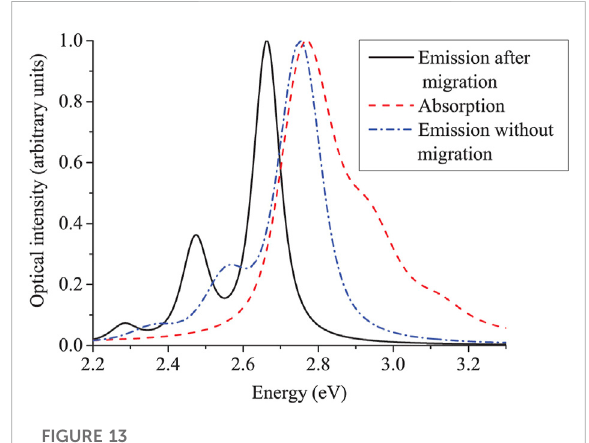
FIGURE 13 The calculated optical spectra of PPV assuming a statistical model of random polymer conformations. Exciton migration prior to emission causes a red-shift in energy, a narrowing of the inhomogeneous broadening, and a decrease in I 00 / I 01 . Reproduced from J. Chem. Phys. 141, 164103 (2014) with the permission of AIP